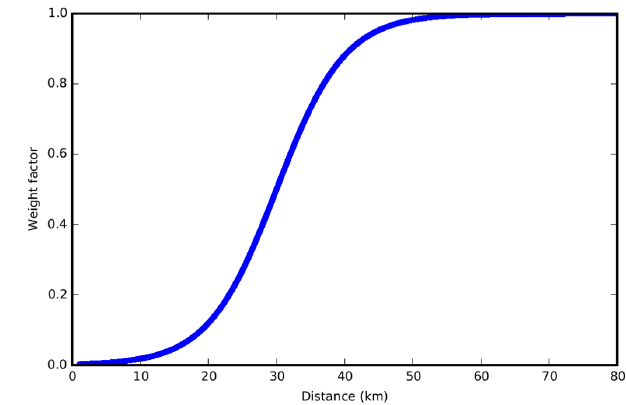
Figure 2. Weights w computed as a logistic function and plotted against distance d . Parameters of the logistic function are described in the